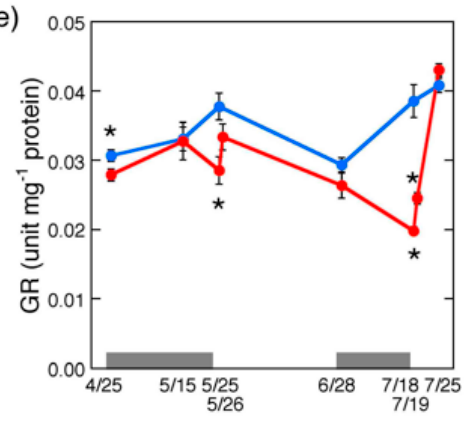
Figure 4. Changes in ROS scavenging enzyme activity in shaded tea leaves after shade removal. Specific activities of superoxide dismutase (SOD) ( a ), ascorbate peroxidase (APX) ( b ), MDA reductase (MDAR) ( c ), DHA reductase (DHAR) ( d ), and glutathione reductase (GR) ( e ) are shown as means ± standard deviation ( n = 3). Gray bars indicate the period of shading treatments. Statistical analysis was performed as described in Figure 3. Asterisks indicate significant differences ( p <